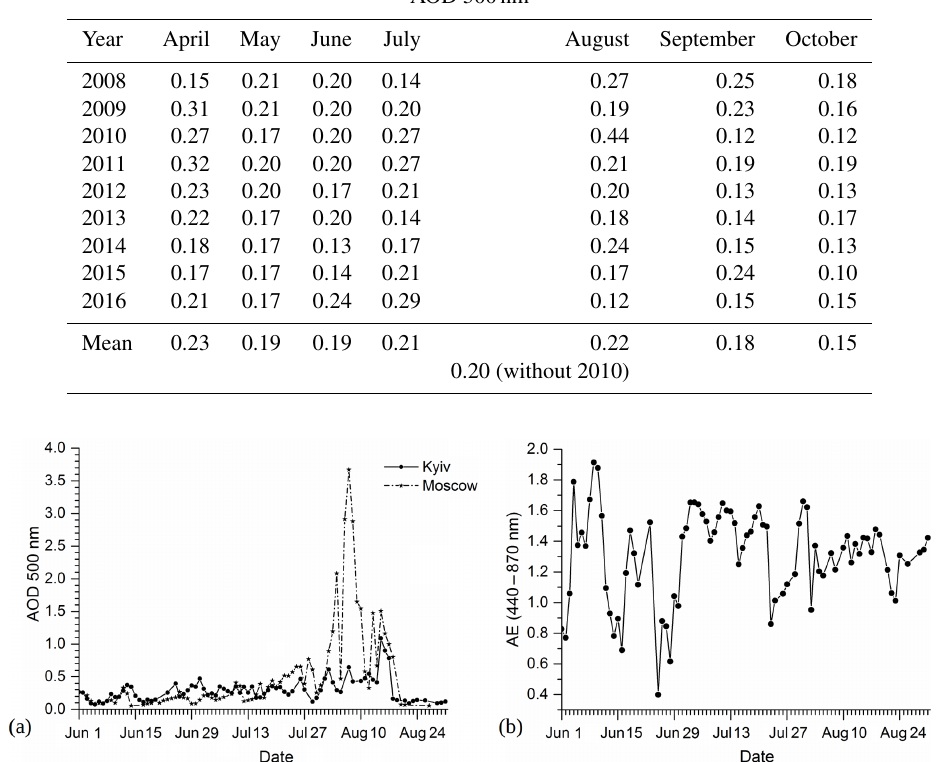
Figure 5. AOD 500nm over Moscow and Kyiv (a) and AE over Kyiv (b) during 1 June–31 August